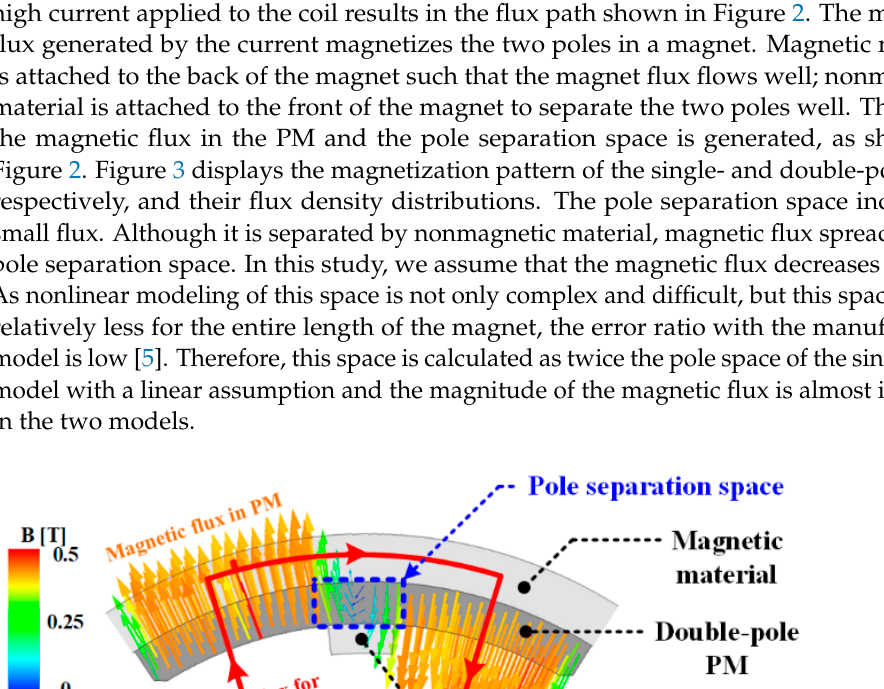
Figure 3. ( a ) Magnetization pattern function. Magnetic flux density distribution: ( b ) Single-pole model and ( c ) double-pole model.